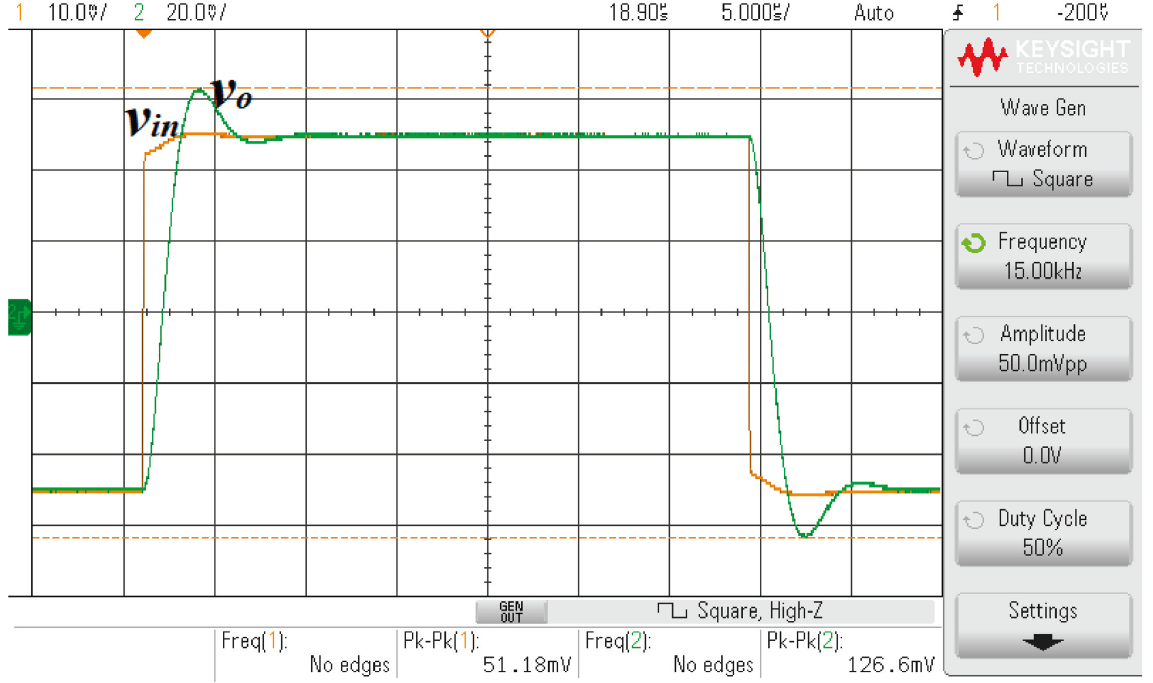
Figure 14: Measured input and output waveform of LP filter.